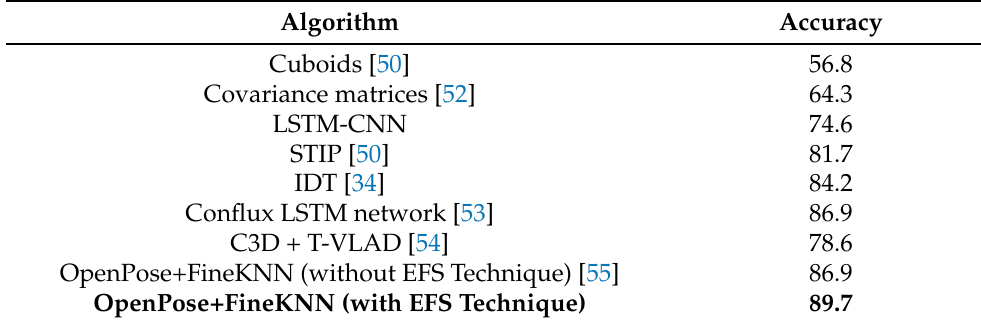
Table 8. Multi-view HAR on MCAD